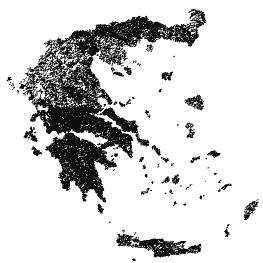
Figure 22. The obstacle set of